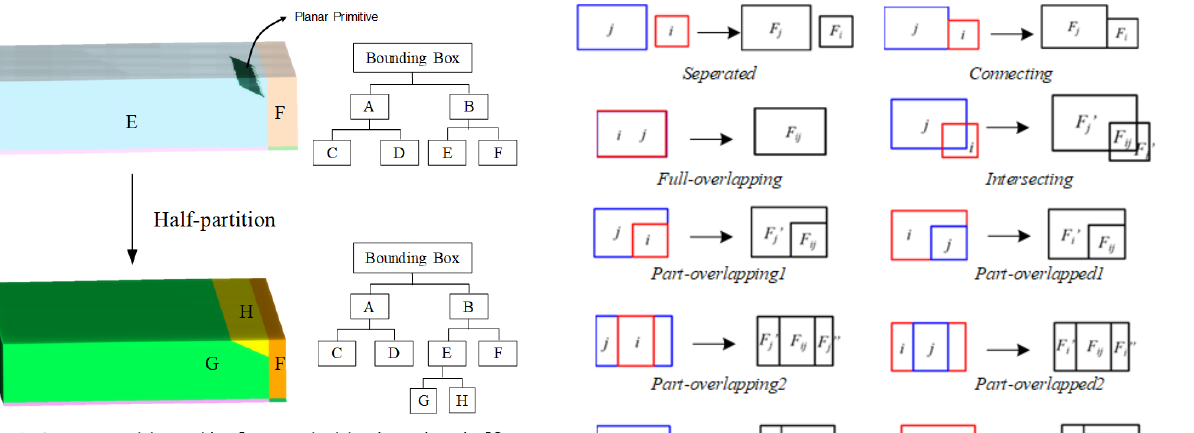
Figure 2. Space partition with planar primitive based on half-cut BSP tree.